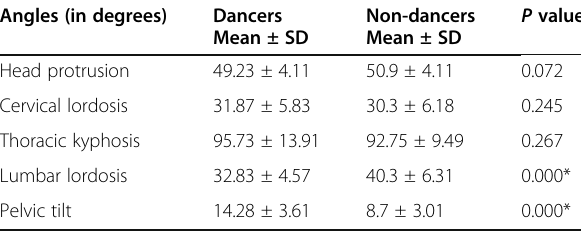
Table 2 Comparison of angles between Bharatanatyam dancers and non-dancers using independent t